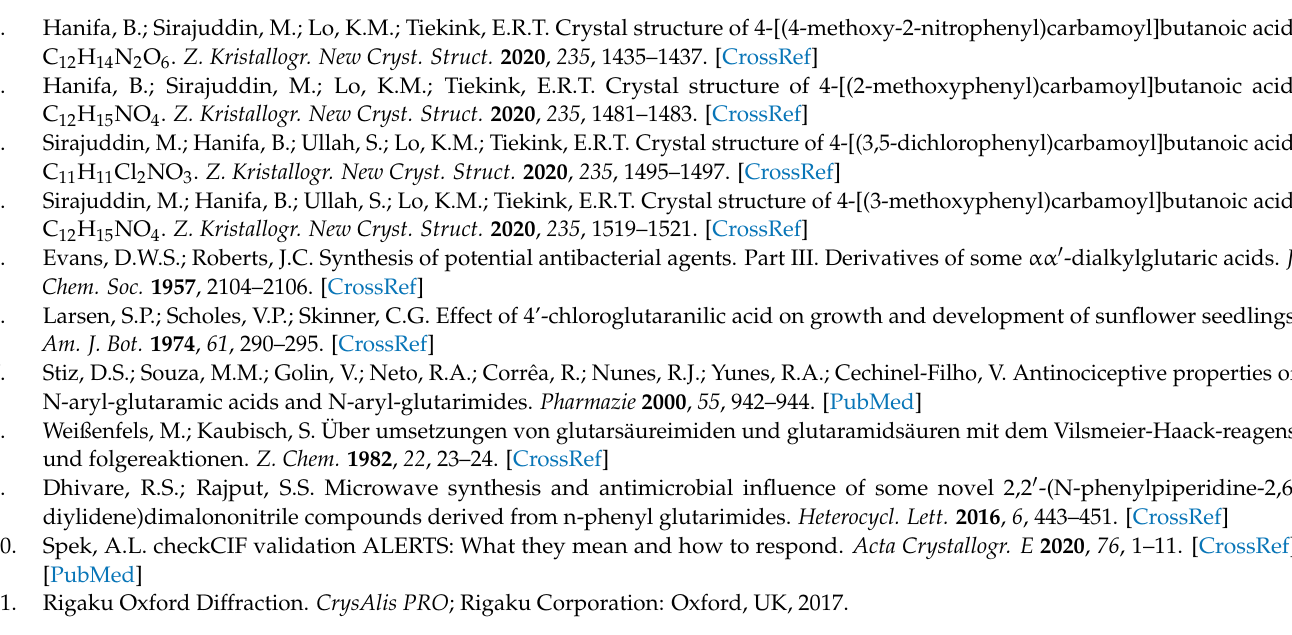
Supplementary Materials: Figure S1: FTIR spectrum of 4-[(4-chlorophenyl)carbamoyl]butanoic acid ( 1 ), Figure S2: 1 H NMR spectrum of 4-[(4-chlorophenyl)carbamoyl]butanoic acid ( 1 ), Figure S3: 13 C{ 1 H} NMR spectrum of 4-[(4-chlorophenyl)carbamoyl]butanoic acid ( 1 ), and Figure S4: UV spectrum of 4-[(4-chlorophenyl)carbamoyl]butanoic acid ( 1 ). Crystallographic data for ( 1 ) in crystal- lographic information file (CIF) format. CCDC 2077071 also contains the supplementary